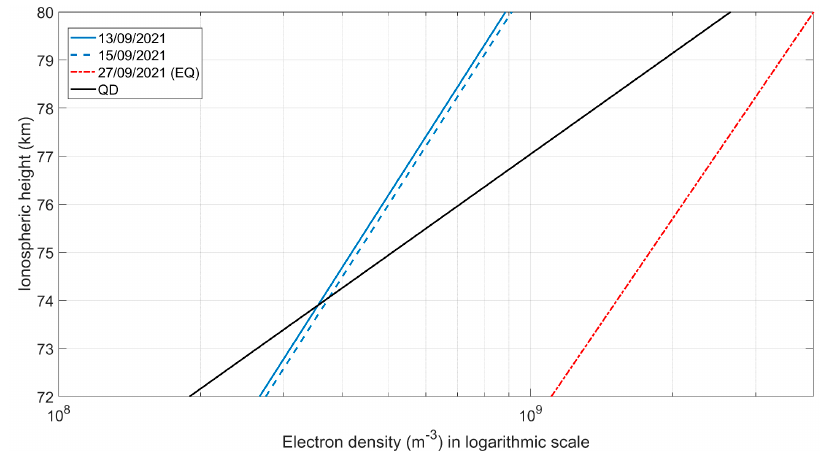
Figure 14. Same as Figure 12 for SST2 of ISR–GER path.